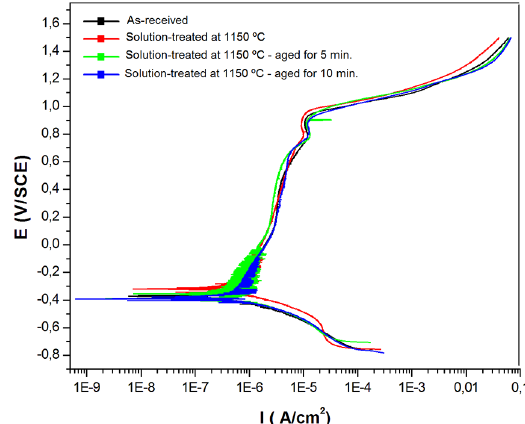
Figure 3. Potentiodynamic polarization curves of UNS S32520 SDSS in the following conditions: as-received, solution-treated at 1150ºC, solution-treated at 1150ºC and aged at 850ºC for 5 and 10 minutes. 3.5% NaCl